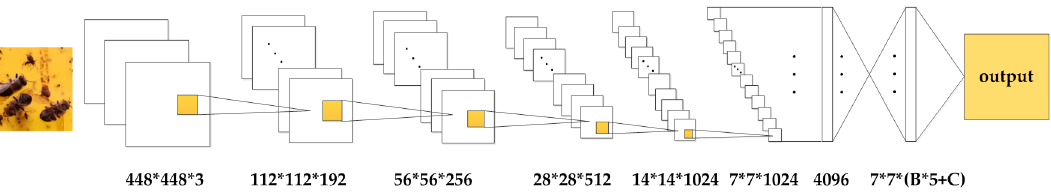
Figure 5. Architecture of YOLO.